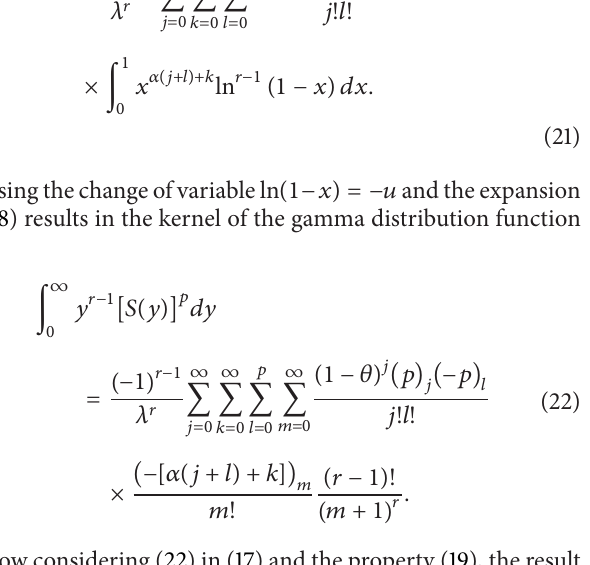
where (𝑟) 𝑘 is a Pochhammer symbol, given (𝑟) 𝑘 = 𝑟(𝑟 + 1) ⋅ ⋅ ⋅ (𝑟 + 𝑘 − 1) and if |𝑥| < 1 the series converge,